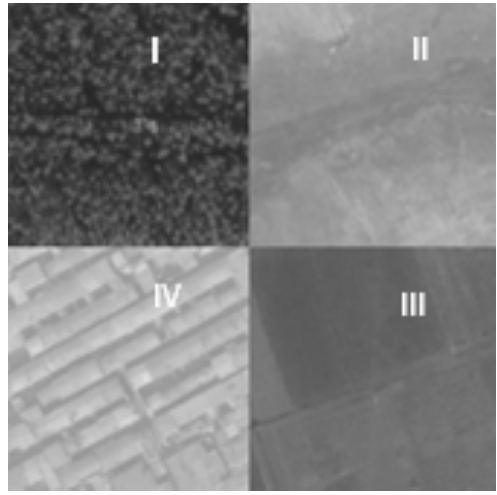
Figure 7. Quick Bird synthetic